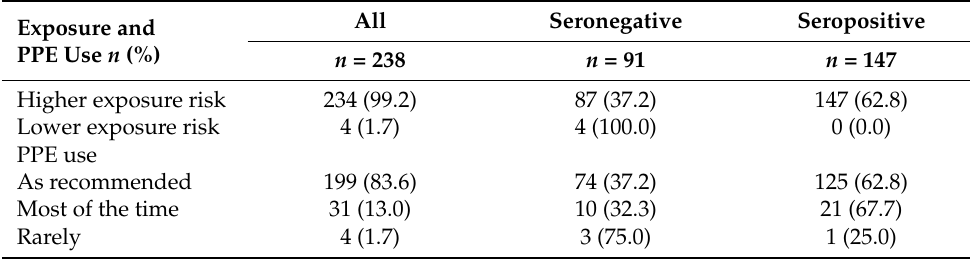
Table 2. Occupational exposure to